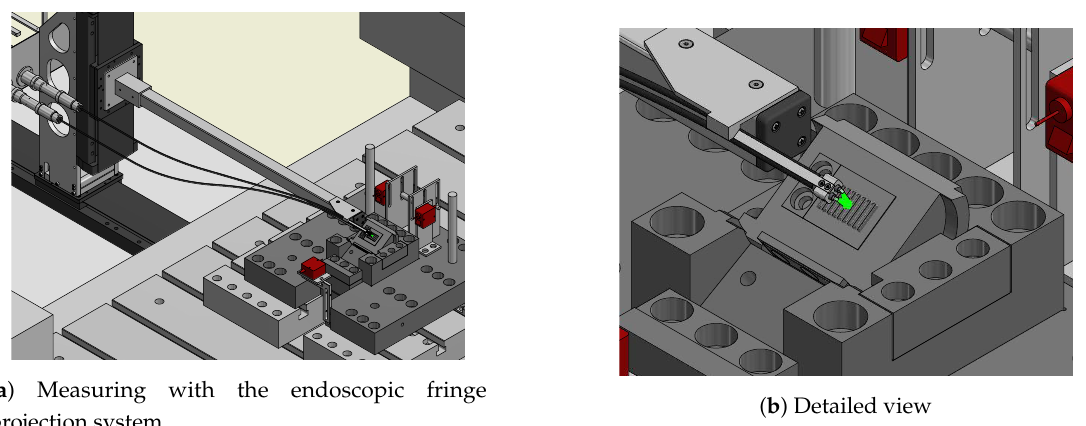
Figure 1. Overview of a possible in-situ measurement inside a metal forming plant (the top elements are hidden for a better perspective).